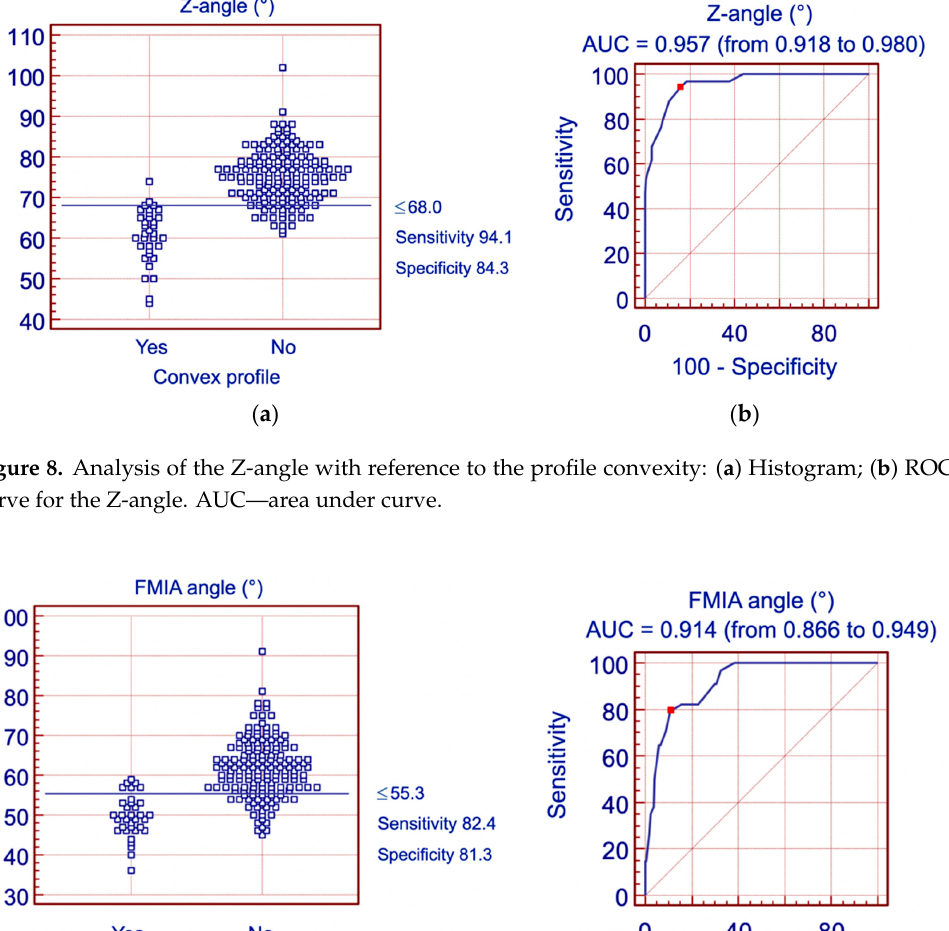
Figure 9. Analysis of the FMIA angle with reference to the profile convexity: ( a ) Histogram; ( b ) ROC curve for the FMIA angle. FMIA – Frankfort mandibular incisor plane angle, AUC—area under curve.